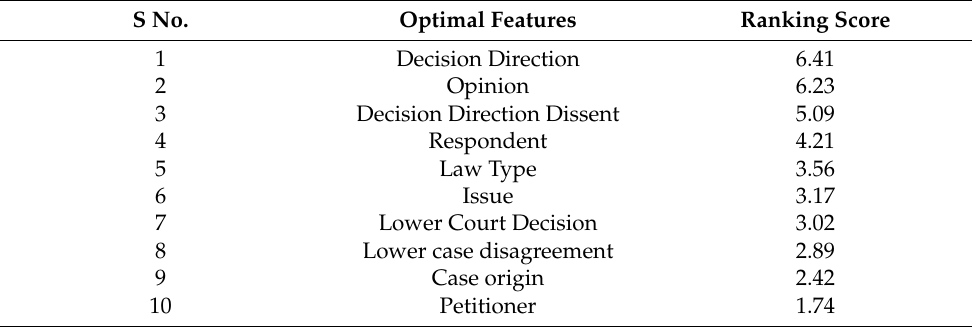
Table 3. A list of optimal features for court